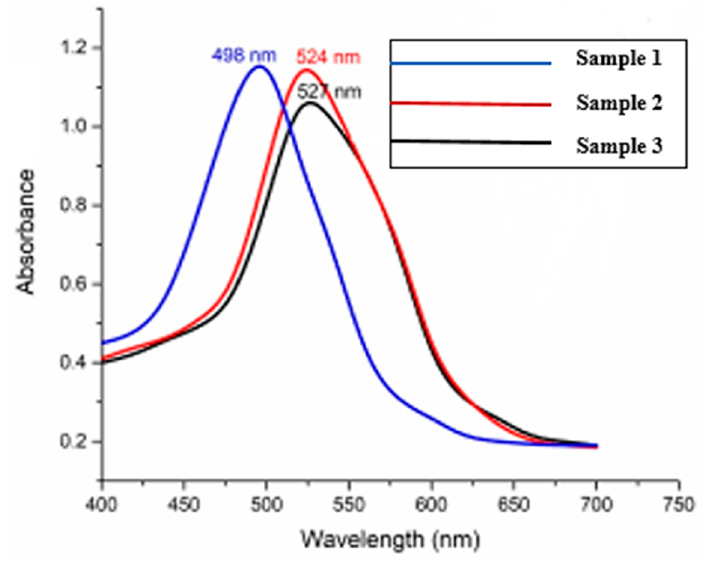
Figure 6. UV-vis spectra of AuNRs produced with 3 mL, 4 mL and 5 mL of AgNO 3 solution.